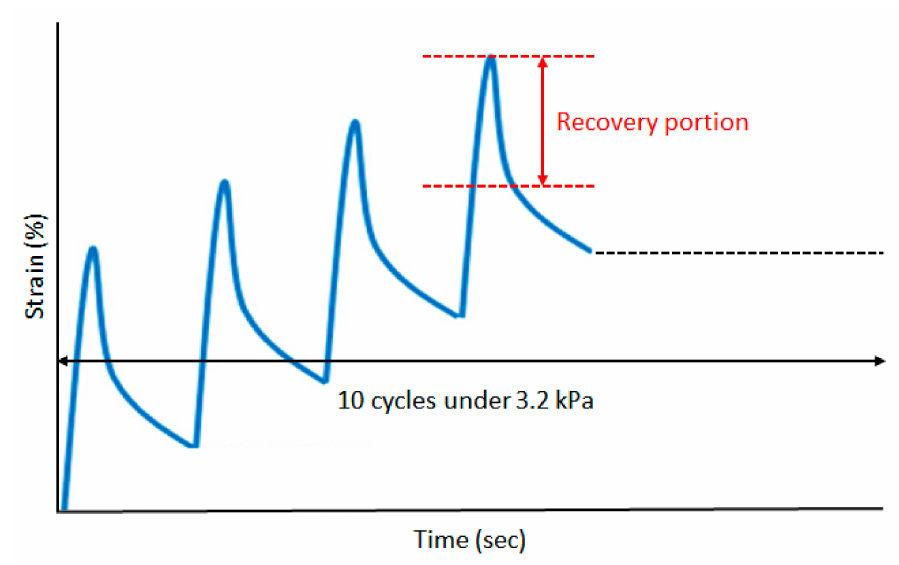
Figure 4. Ten cycles of creep and recovery at 3.2